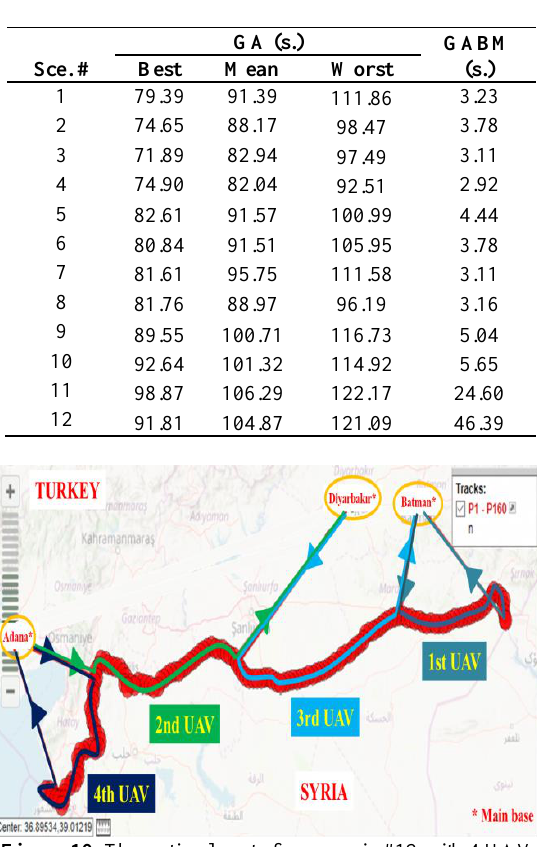
Table 5. The CPU times.